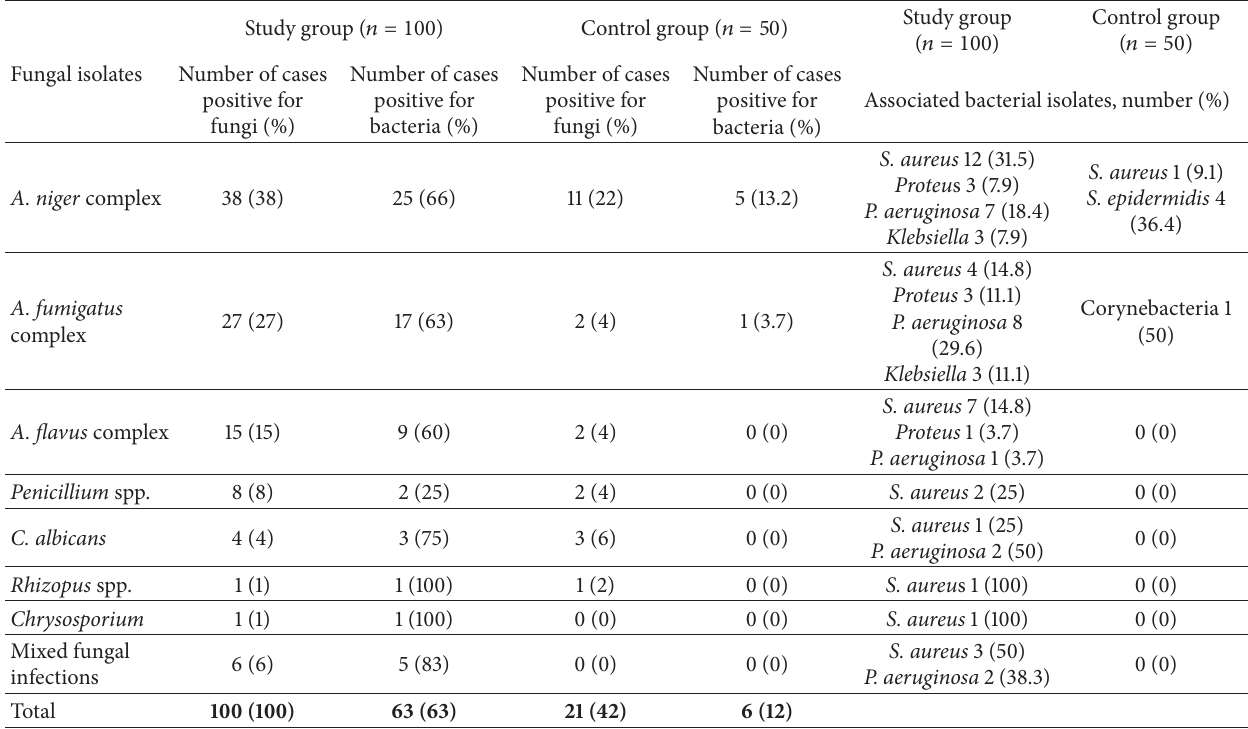
Table 2: Fungi-bacteria association in study (otomycosis) and control